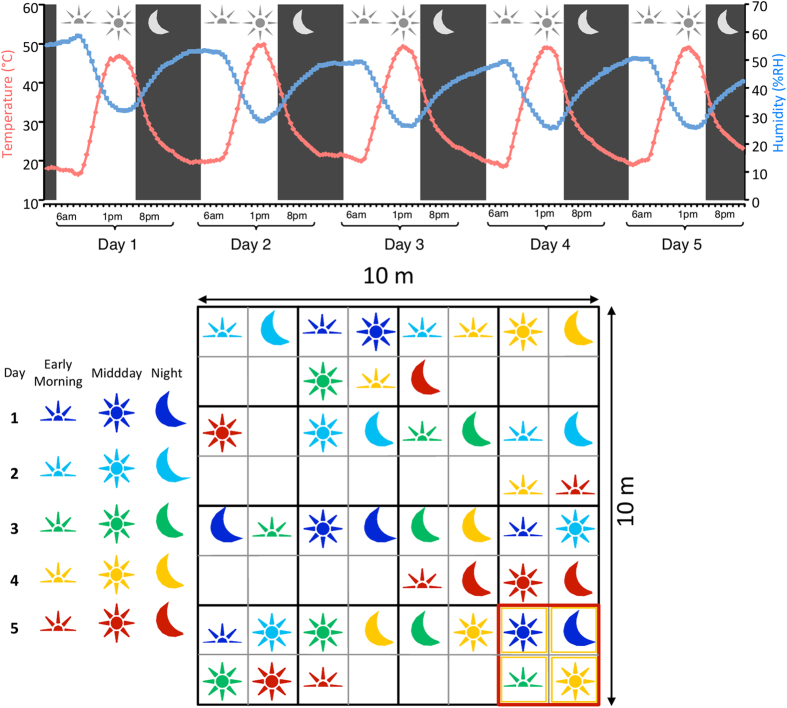
Experimental design and environmental parameters (temperature & humidity) measured over the 5-day study at a local site adjacent to the Gobabeb Training and Research Centre, Namib Desert.